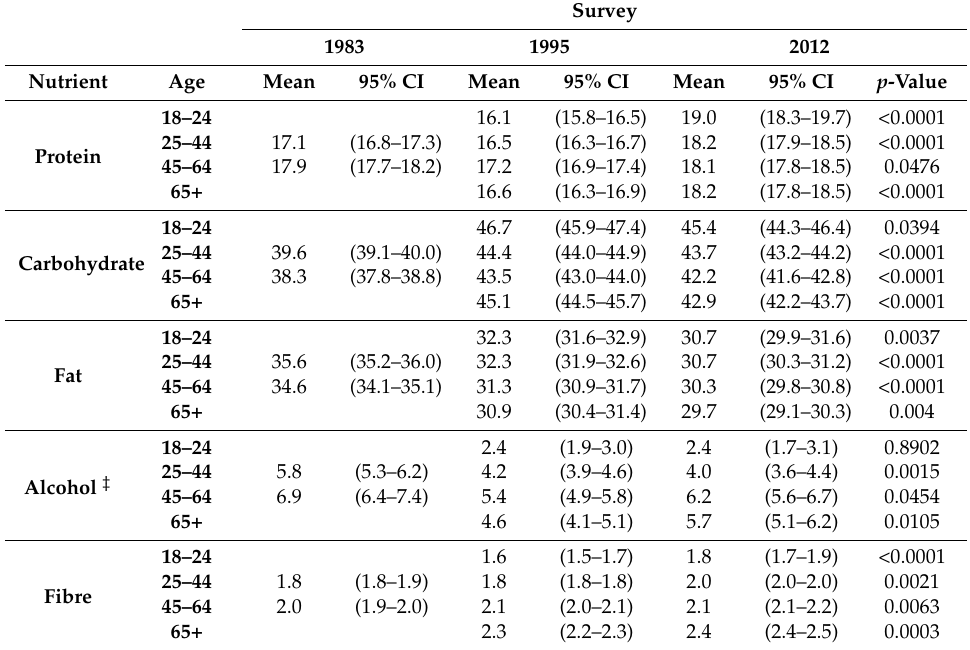
Table 3. Change in percentage energy (%E) from macronutrients for Australian men by age group between 1983 ( n = 3021), 1995 ( n = 5146) and 2012 ( n = 4329) for men from three national nutrition